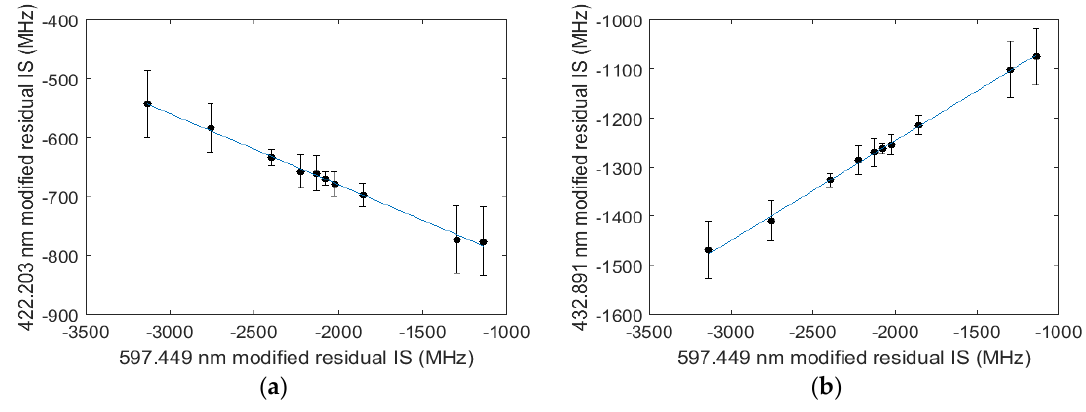
Figure 3. King plots of modified residual IS (see text) of pairs of transitions in Dy II and Dy I. The mass pair (160, 164) has been chosen as the reference, and points have been plotted for all unique pairs of isotopes. The straight line (blue online) is a linear least-squares fit. Note that the error bars in the horizontal direction are smaller than the data symbols. ( a ) King plot for the 422.201 nm vs. 597.449 nm transitions; ( b ) King plot for the 432.891 nm vs. 597.449 nm transitions.